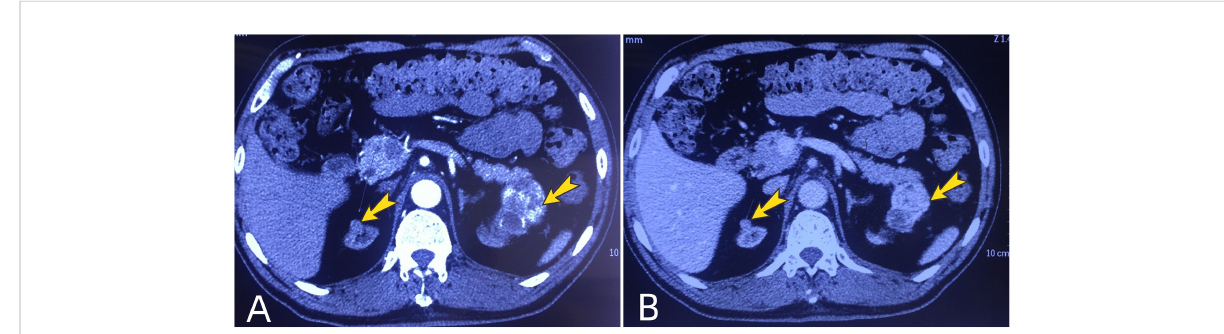
FIGURE 1 Preoperative renal enhanced computed tomography. Arrows show the tumors in the upper poles of bilateral native kidneys. (A) the tumors are enhanced in the cortical phase; (B) The enhancement of tumors is markedly reduced in the medullary phase, showing the performance of “ fast in and fast out ”